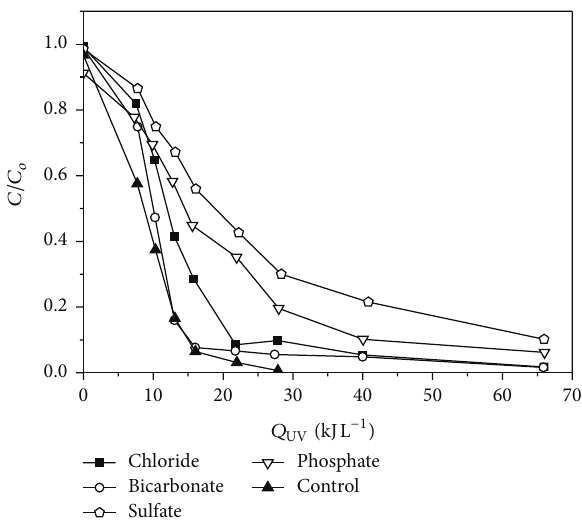
Figure 4: Effect of inorganic anions (2.5 mM) on decolorization of IC (30mgL −1 ) with 0.1 gL −1 TiO 2